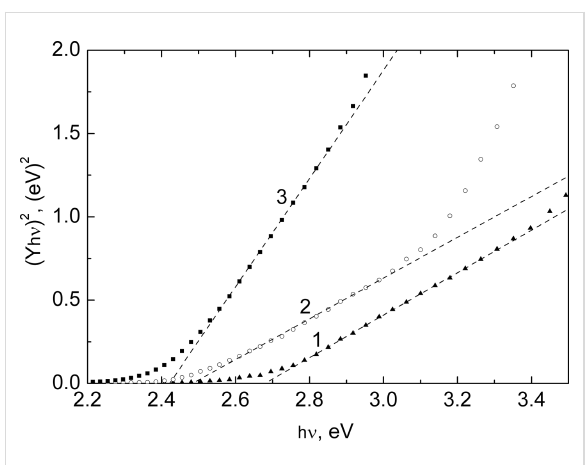
Figure 10: Analysis of the photocurrent spectra shown in Figure 9 in coordinates of (Y· h ν ) 2 versus h ν typical for direct optical transitions for In 2 O 3 (400)/CdS film electrodes. The number of the SILAR cycles of CdS deposition was 10 (1), 30 (2) and 50